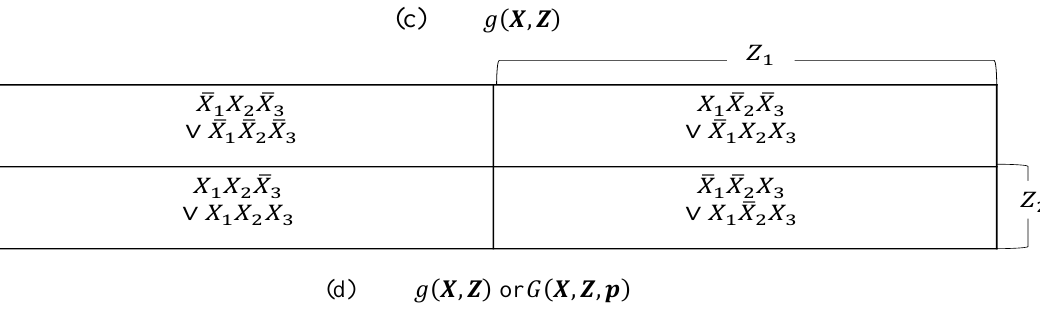
Fig. 7. Gradual development of the natural map for 𝑔(𝑿, 𝒁) obtained by suppressing 𝒀 from ℎ(𝑿, 𝒀, 𝒁) in Fig. 6. The final map in 7(d) also represents the auxiliary function 𝐺(𝑿, 𝒁, 𝒑)